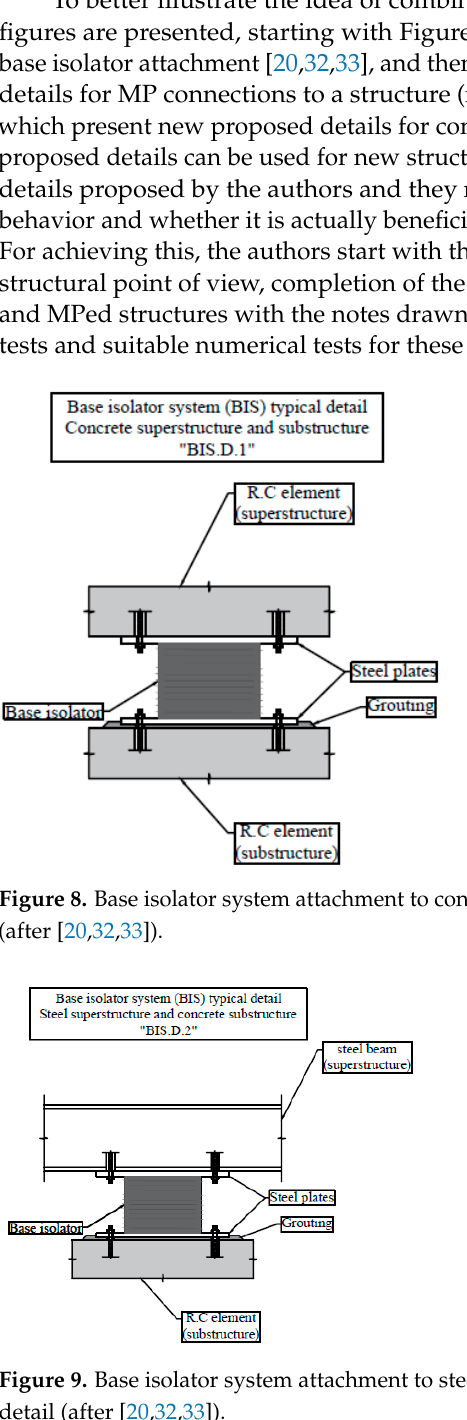
Figure 10. Base isolator system attachment to steel superstructure and concrete substructure— typical detail (after [20,32,33]).